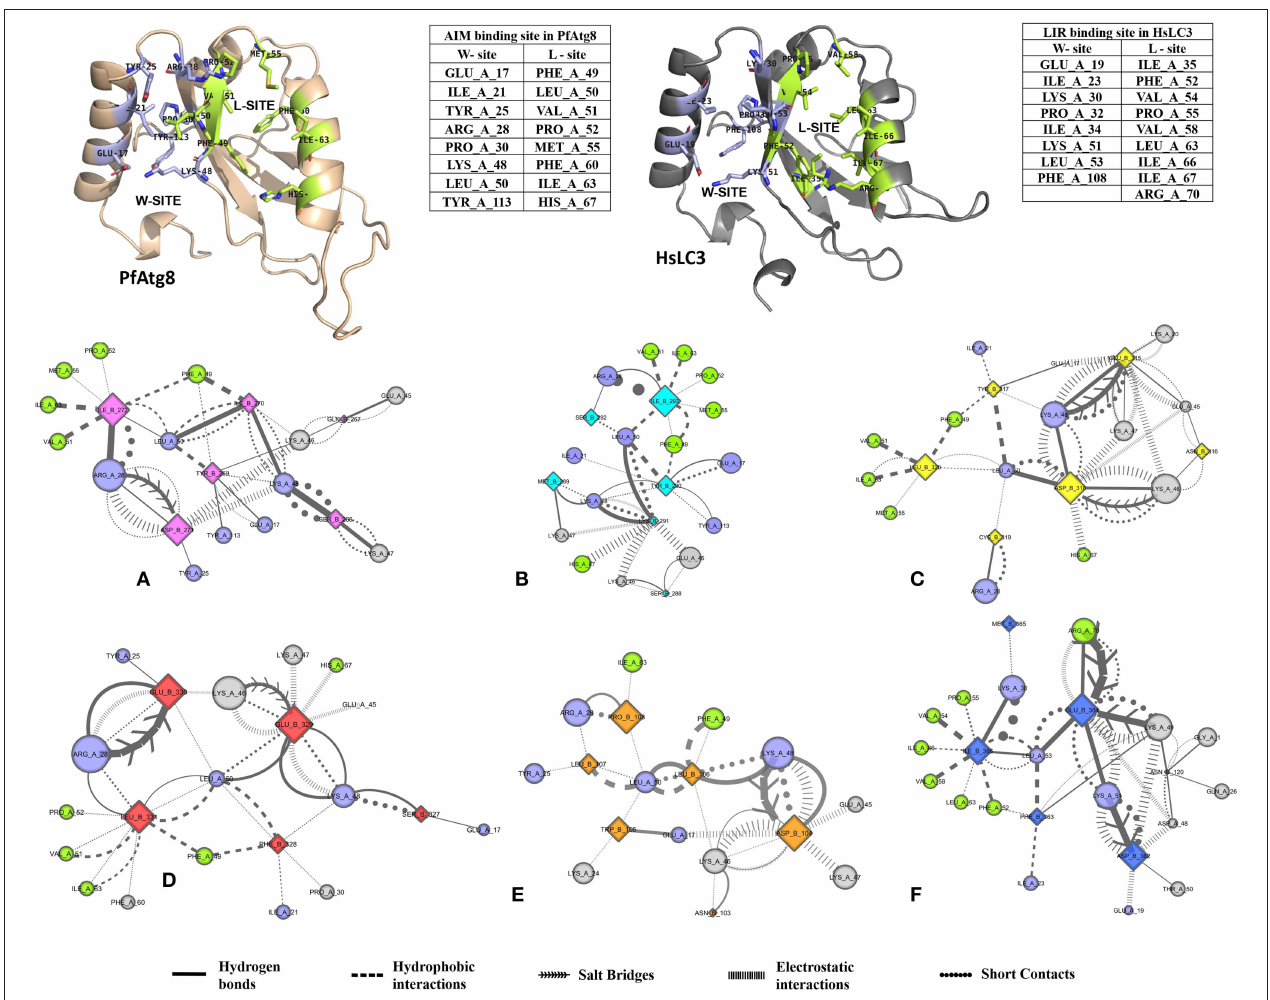
FIGURE 5 | Non-covalent bond interactions in AIM/LIR - Pf Atg8/ Hs LC3 complexes. (A) Pf Sec62 QSYIDI (magenta), (B) Pf Sec62 SMYKSI (cyan), (C) Pf Sec62 ENYDCL (yellow), (D) Pf Sec62 TSFEEL (red) and (E) Pf Atg3 NDWLLP (orange) LIR motifs bound to Pf Atg8 and (F) Hs Sec62 NDFEMI (blue) bound to HsLC3. The upper panels show W-site and L-site in Pf Atg8 and Hs LC3 in cartoons and adjacent tables detail the residues composing the respective binding sites. The non-covalent bond interactions between the AIM/LIR motifs and Pf Atg8/ Hs LC3 are represented as network maps shown as different line types.